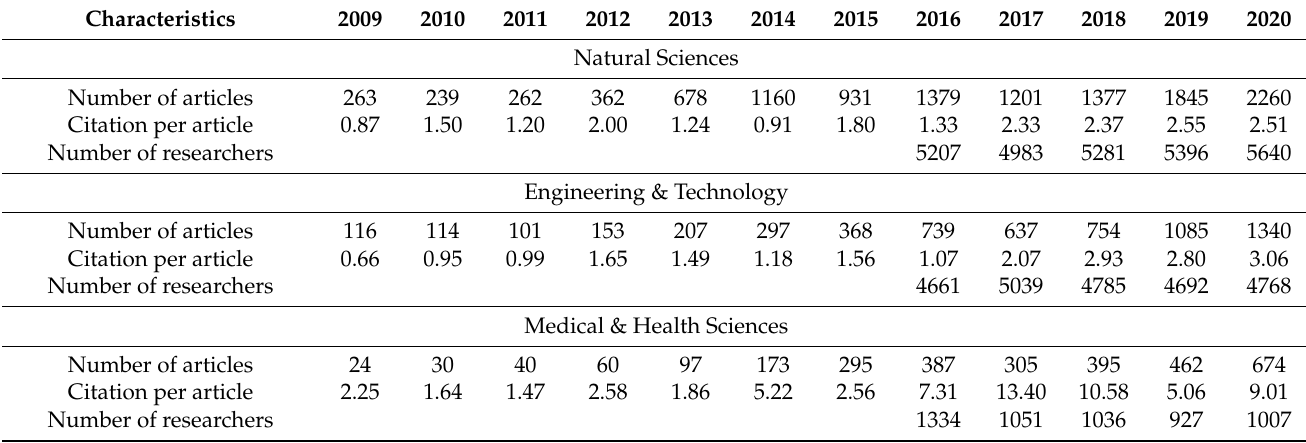
Table 4. Key publication characteristics across OECD’s six fields of